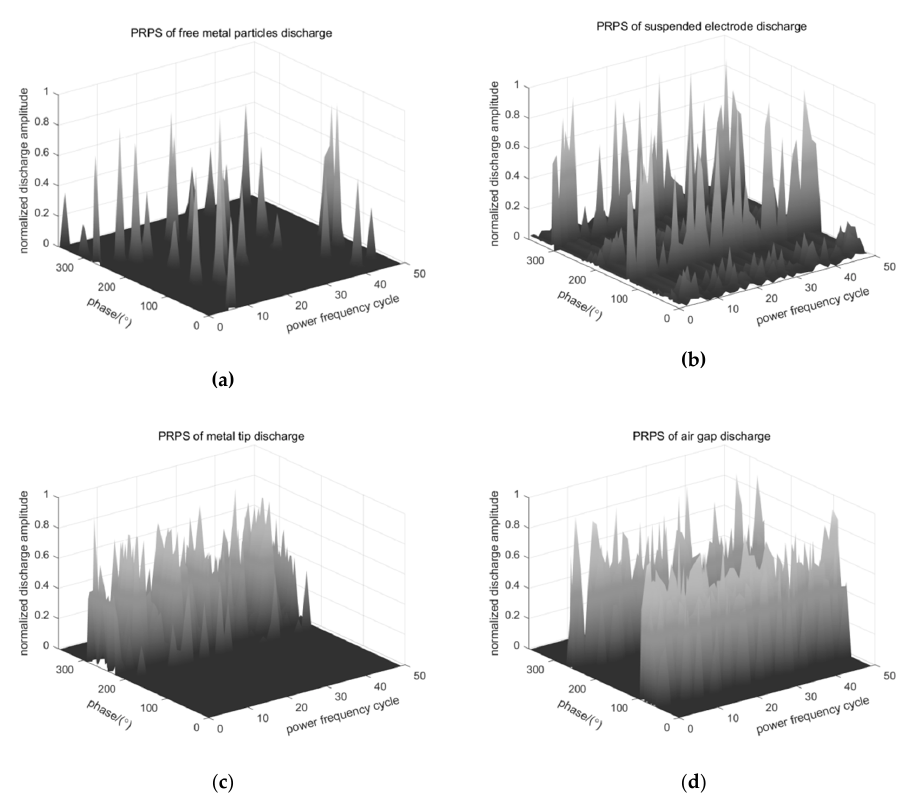
Figure 4. 3D PRPS graphs under four types of insulation defects ( a ) 3D graphs of phase resolved pulse sequence (PRPS) under free metal particles defect at 13 kV; ( b ) 3D graphs of PRPS under suspended electrode defect at 22.6 kV; ( c ) 3D graphs of PRPS under metal tip defect at 6.5 kV; ( d ) 3D graphs of PRPS under air gap defect at 5.5